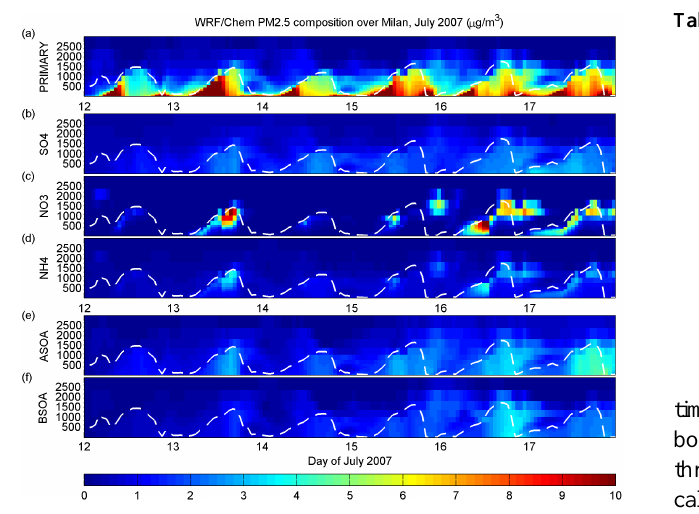
Figure 7. Simulated composition of PM 2 . 5 profile shown in Fig. 6. ASOA and BSOA in panels (e, f) are anthropogenic and biogenic secondary organic aerosol, respectively.